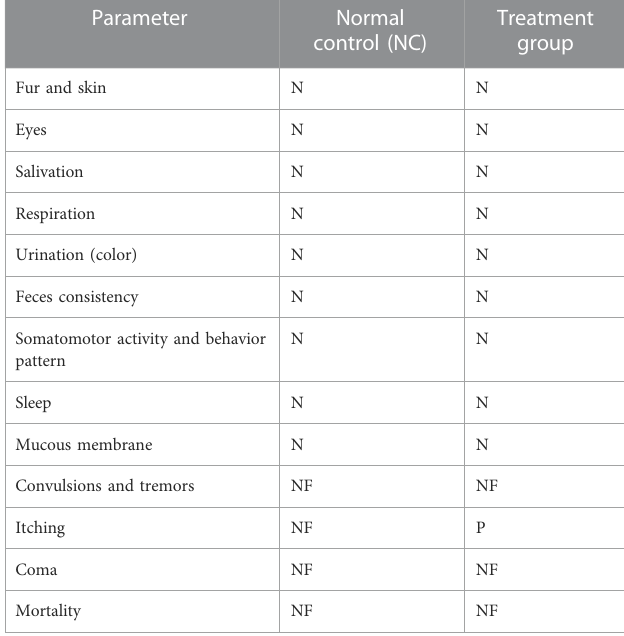
TABLE 1 Behavioral changes after treatment with a single dose of fenchone (F) (2000 mg/kg) in the acute oral toxicity study when compared to those of the normal